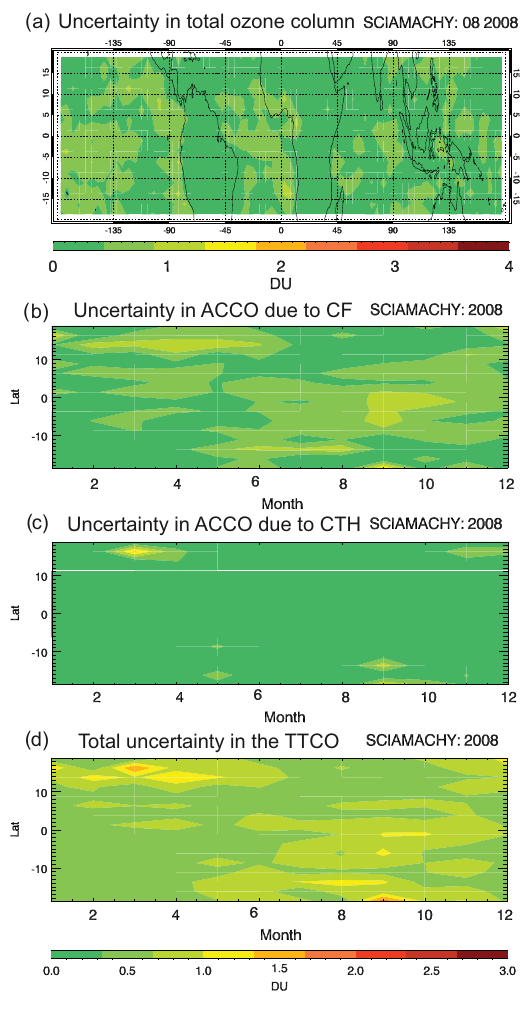
Figure 7. (a) The uncertainty in the WFDOAS TCO retrieval in August 2008 using GOME-2 (b) the uncertainty in the monthly av- eraged zonal ACCO due to CF for 2008 using GOME-2 data (c) the uncertainty in the monthly averaged zonal ACCO due to CTH for 2008 using GOME-2 data (d) the total uncertainty in the TTCO using the CCD method and GOME-2 WFDOAS total ozone data in